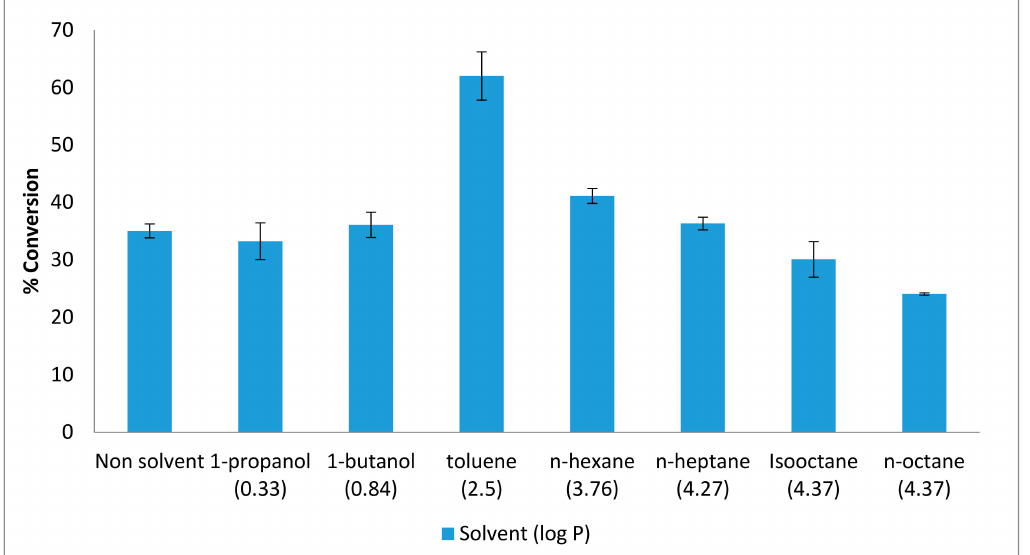
Figure 1. Effect of various organic solvents on lipAMS8 lipase. Percentage conversion of ethyl hexanoate catalysed by native AMS8 lipase as affected by various organic solvents in different polarity (log p value) and solvent-free system. Reactions were performed at 20 ◦ C for two hours with 1:1 molar ratio of hexanoic acid to